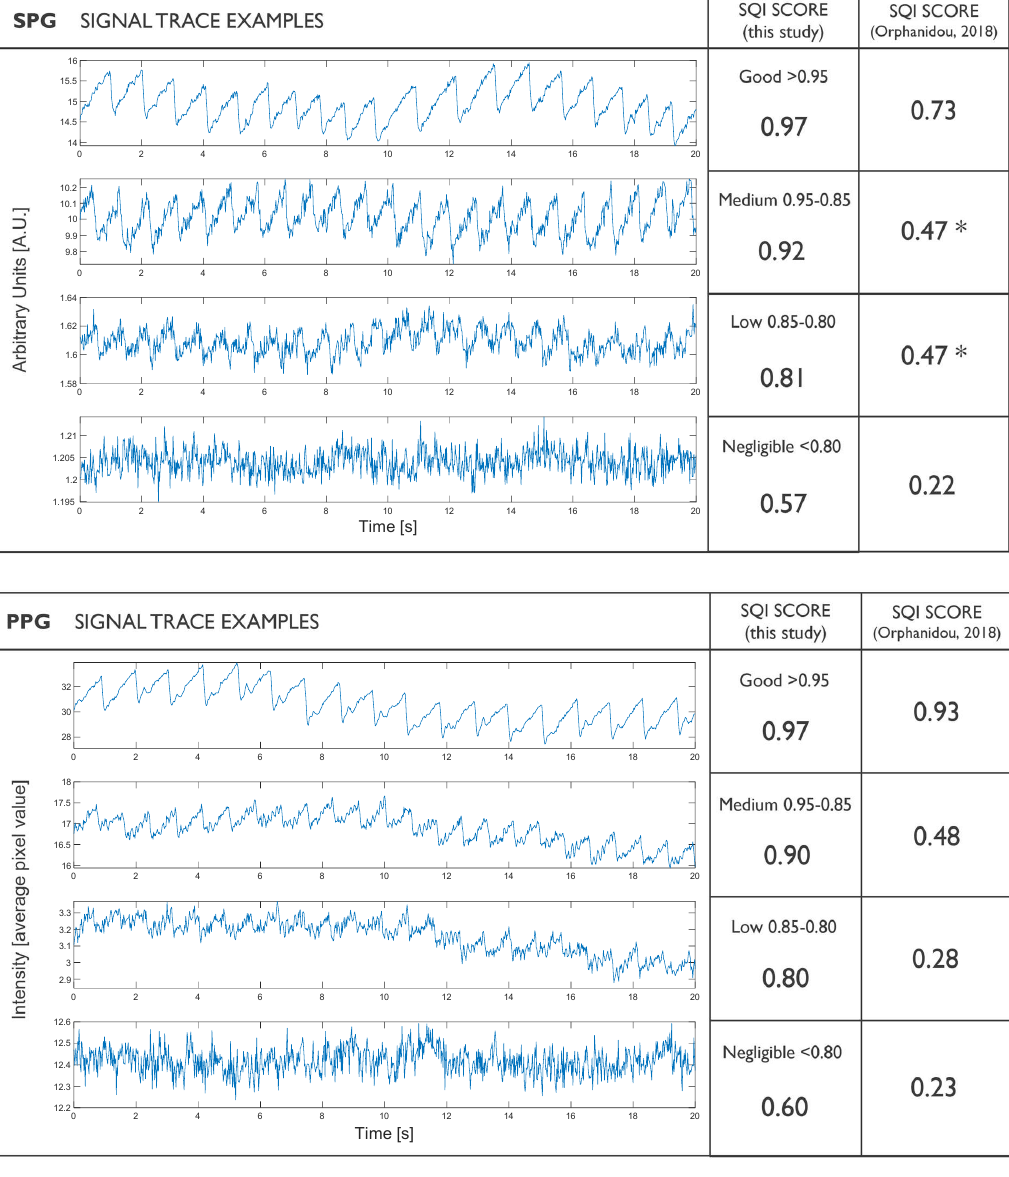
coherent light, the measurements showed negligible heart-rate components in both domains. Only the NIR LED shows a smooth HR component in the intensity domain, but it is likely not sufficient to calculate HRV.